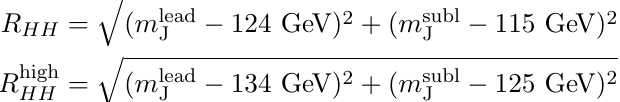
Figure 6. The m lead vs m subl distribution of the background model in the boosted two-tag sample. J J The signal region is the area surrounded by the inner (red) dashed contour line, centred on ( m lead =124 GeV, m subl =115 GeV). The control region is the area between the signal region and the J intermediate (orange) contour line. The sideband region is the area between the control region and the outer (yellow) contour